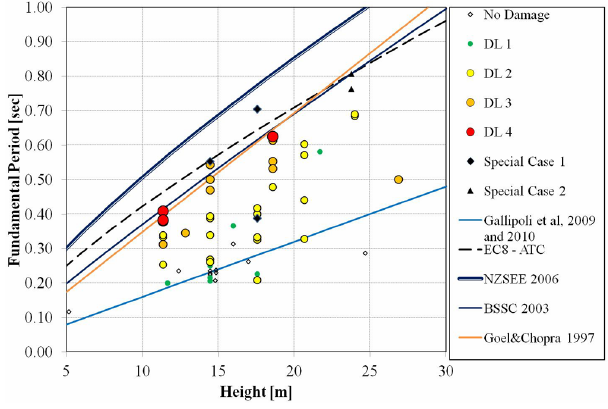
Fig. 5. Correlation between height, period and damage level, and comparison with code formulas.